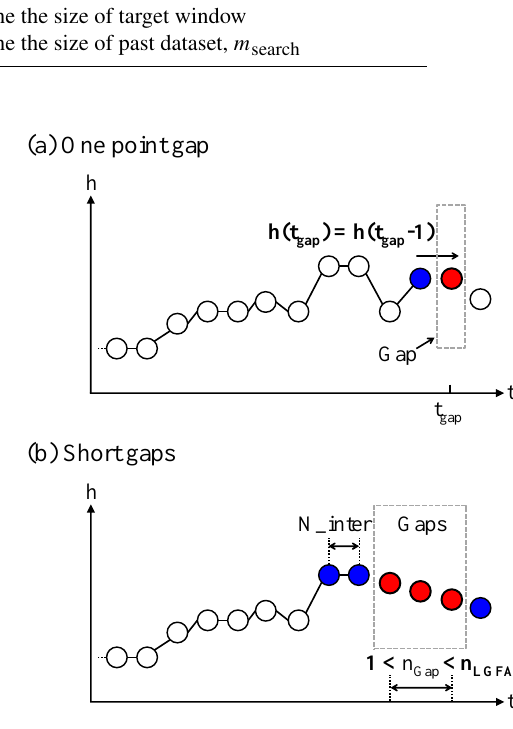
Figure 5: Schematic sketch of SGFA of the gap filling Figure 5. Schematic sketch of SGFA of the gap-filling algorithm: algorithm: (a) one point gap, (b) short gaps. The water- (a) one point gap, (b) short gaps. The water level data are repre- level data are represented as circles and a gray dotted sented as circles, and a gray dotted box indicates the location of box indicates the location of gaps. Blue circles indicate gaps. Blue circles indicate the data used to fill the gaps and red cir- the data used to fill the gaps and red circles indicate cles indicate gap-filled gap-filled data.